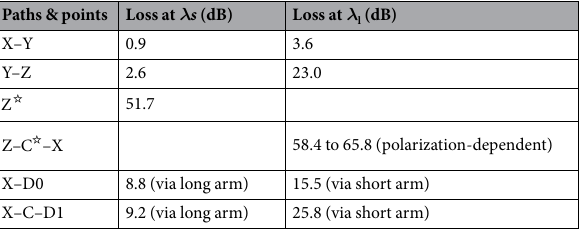
Table 1. Comparison of optical losses in Bob at λ s versus λ l . See Fig. 1 for location of the paths and points. The loss during